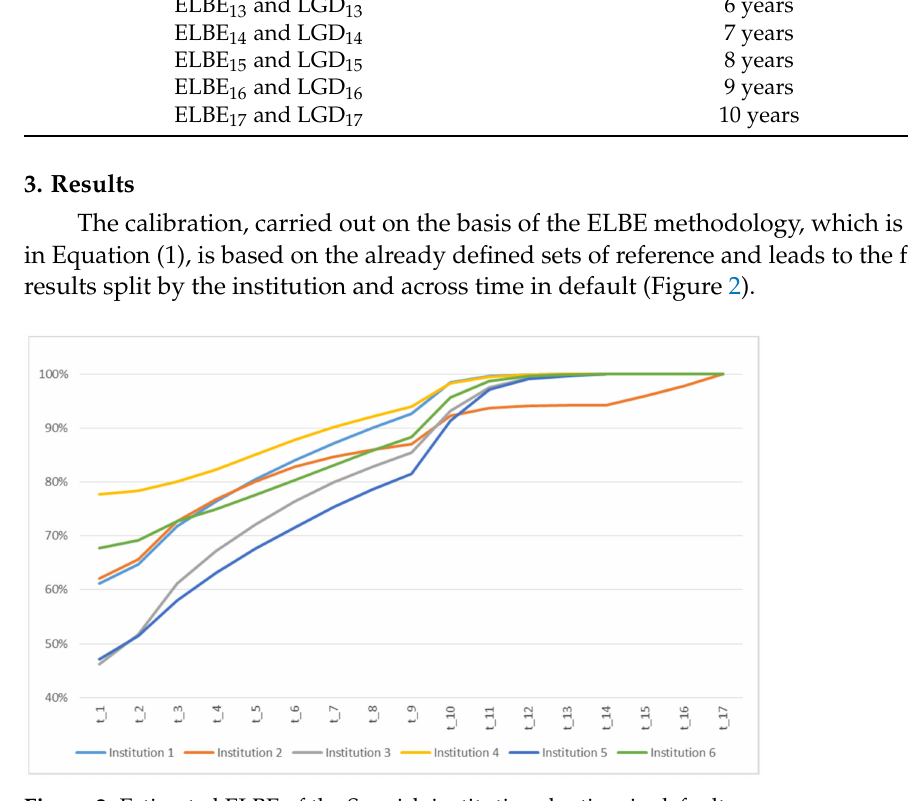
Figure 2. Estimated ELBE of the Spanish institutions by time in